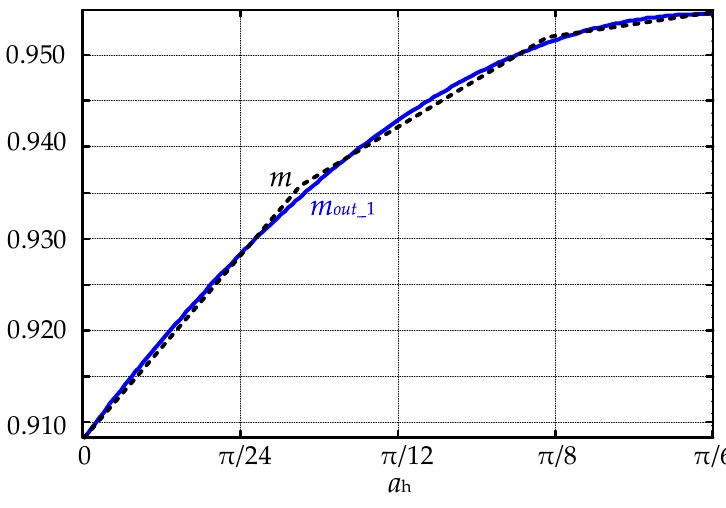
Figure 7. m out_ 1 and m related to a h .